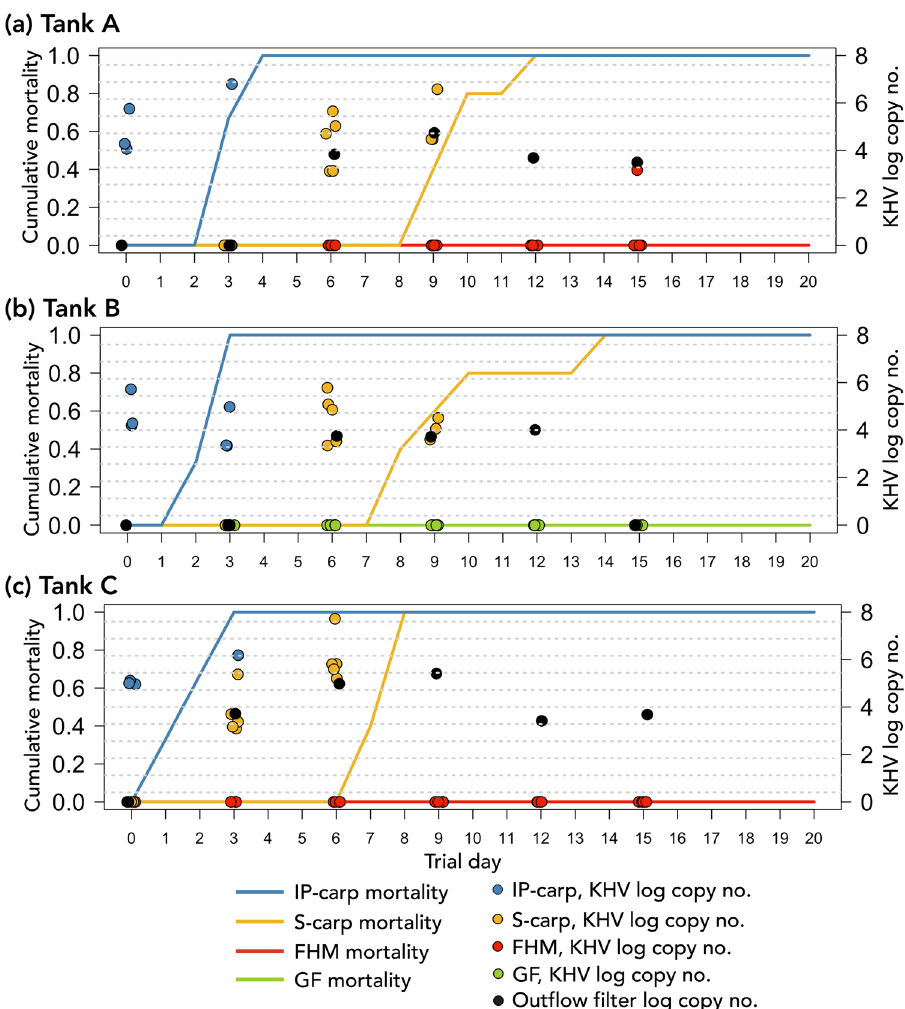
Figure 5. ( a – c ) The cumulative mortality and CyHV-3 log copy number/mL of fishes in experimental cohabitation tanks. IP-carp intraperitoneally injected carp, S-carp cohabitated sentinel carp, FHM fathead minnow, goldfish. “Trial day” indicates days post introduction of IP carp into cohabitation tanks. Points indicating log copy number are jittered to aid in